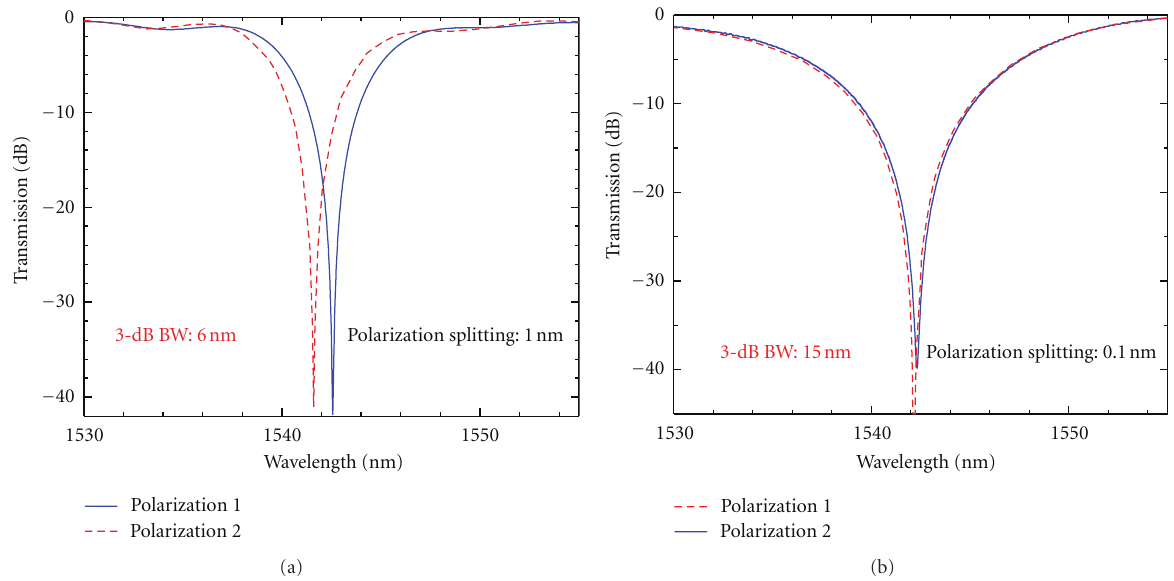
Figure 15: Measured spectral transmission responses of the LPG di ff erentiators used (a) on the [25] (results shown in Figures 10–14) and (b) on the [26] (results shown in Figure 16) for the two orthogonal input light polarization states.